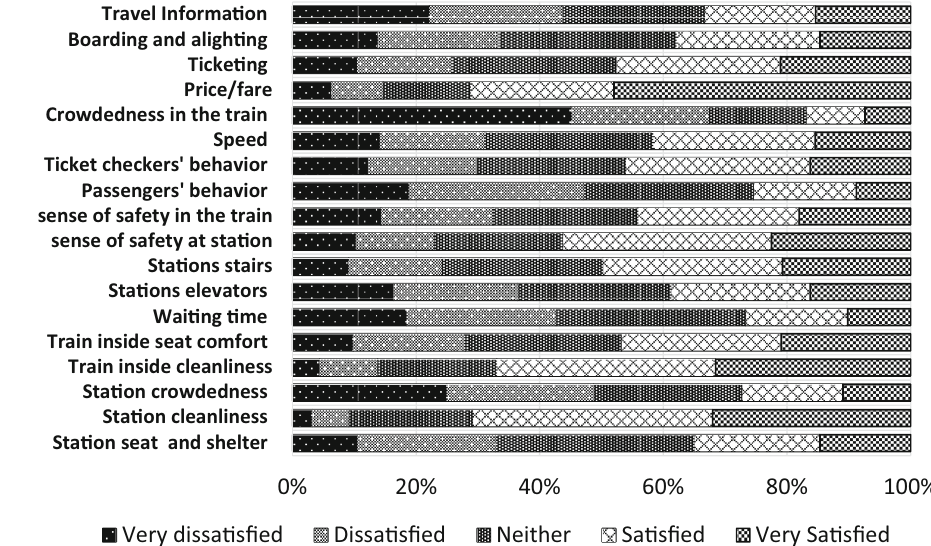
Fig. 2 Satisfaction towards AALRT service quality